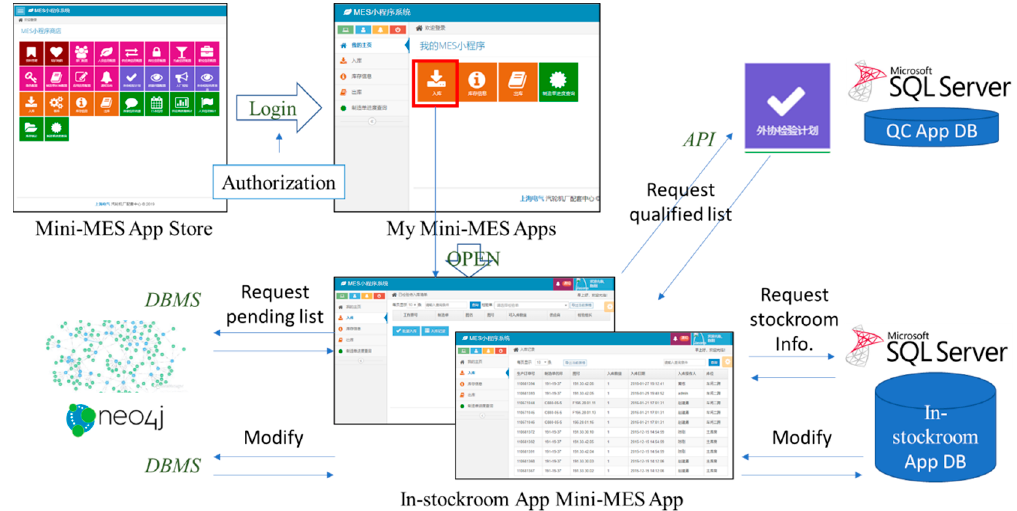
Figure 11. User interface and data interaction of the In-stockroom App.